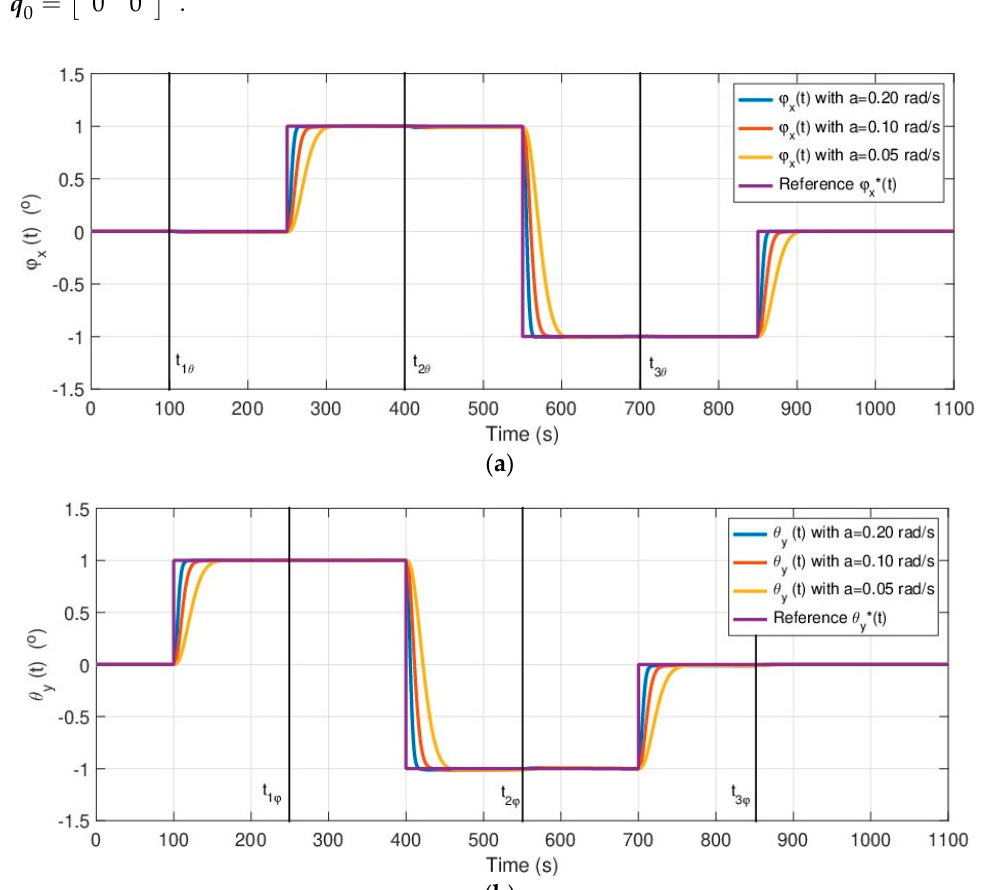
Figure 12. Step responses for different gains of the controllers. ( a ) Step responses for the x-axis rotation. ( b ) Step responses for the 𝑦 -axis rotation.